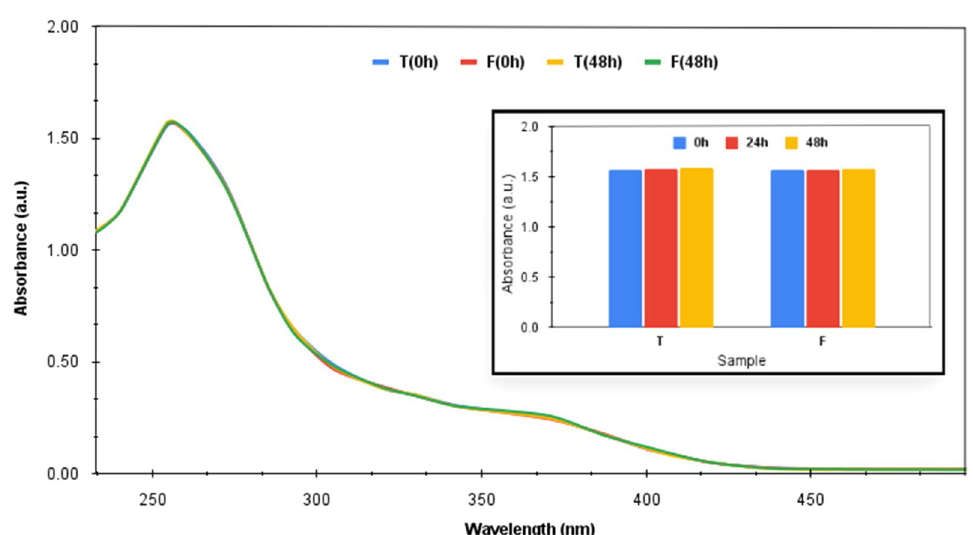
Figure 9. UV–visible absorbance plot at different time intervals for incubated NBT solution along with TiO 2 NPs and Fe@TiO 2 NPs separately. The inset compares the individual performances of TiO 2 NPs and Fe@TiO 2 NPs over the period of